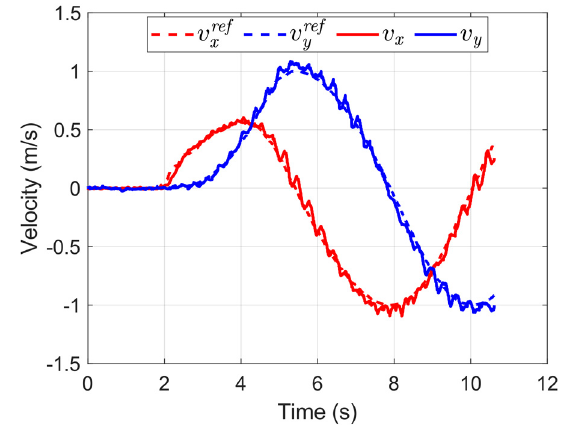
Figure 7. Horizontal locomotion under original MPC.